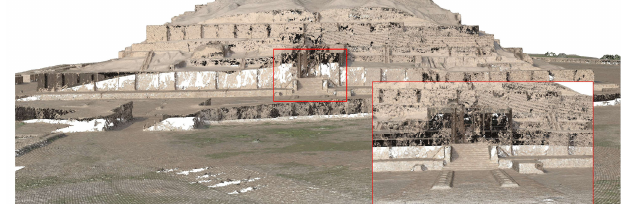
Figure 15. Facade view of the NUAV cloud representing different level of details.